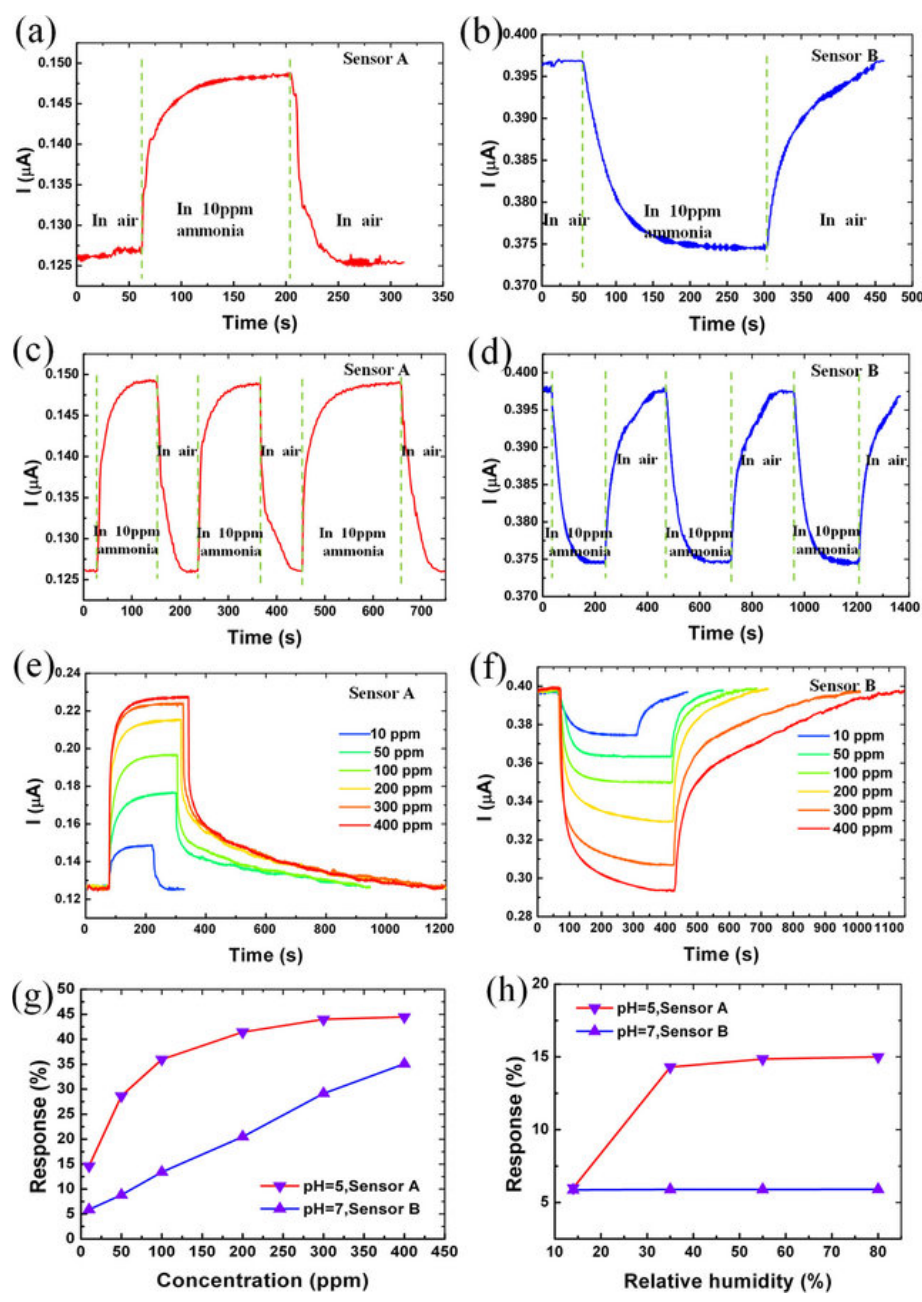
Figure 6. ( a , b ) 10 ppm NH 3 gas response characteristic of sensors A and B, respectively. ( c , d ) Response of sensors A and B to 10 ppm NH 3 gas for three cycles, respectively. ( e , f ) Current response behavior for sensors A and B at different concentrations of NH 3 ambience ( g ) absolute response of sensors A and B at various concentrations of NH 3 gas ( h ) absolute response of sensors A and B to 10 ppm NH 3 gas at various relative humidity. Reproduced from Rahimi, K. and Yazdani, A., 2018. Ethanol-sensitive nearly-aligned ZnO nanorod thin films covered by graphene quantum dots. Materials Letters , 228 , pp. 65 – 67 [151].